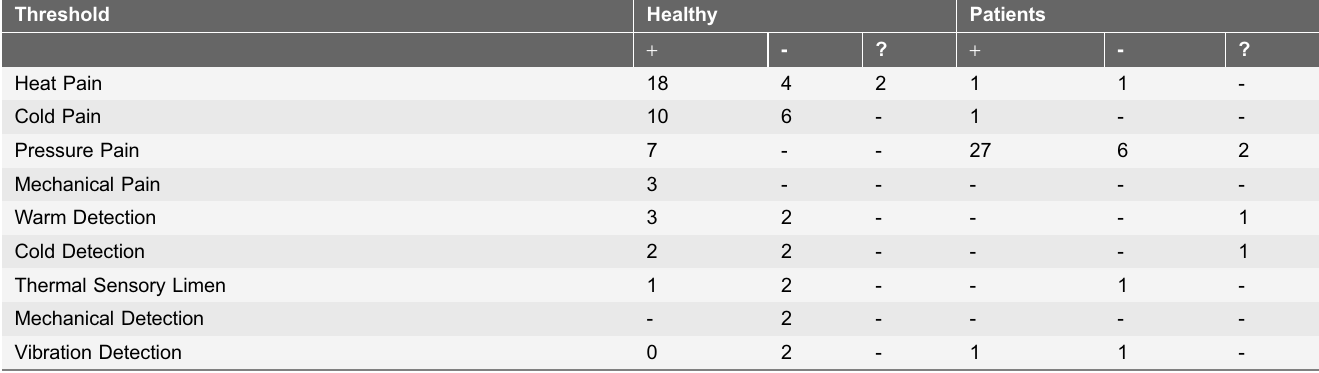
Table 3. Overall Study